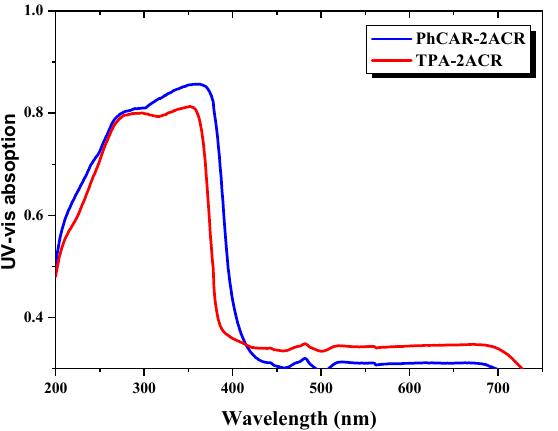
Figure 2. UV ‐ vis absorption (in toluene) spectra of PhCAR ‐ 2ACR and TPA ‐ 2ACR.